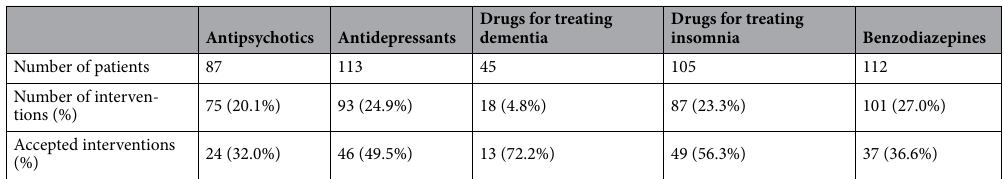
Drugs for treating dementia